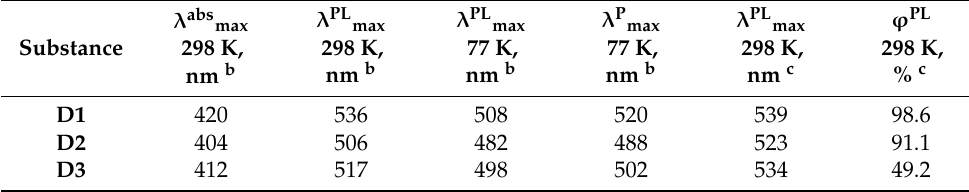
Table 1. Absorption and emission characteristics of 3a – c at 298 and 77 K a . λ abs Substance